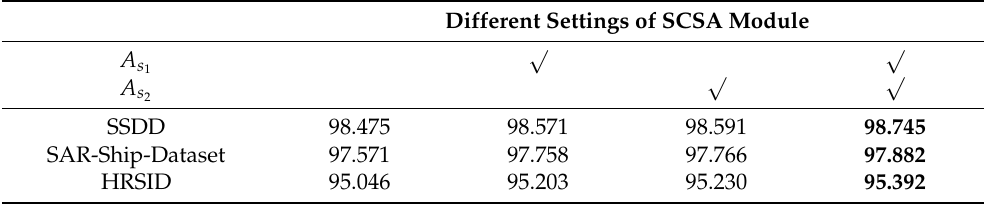
√ indicates that the corresponding item is used. The best results are bold.